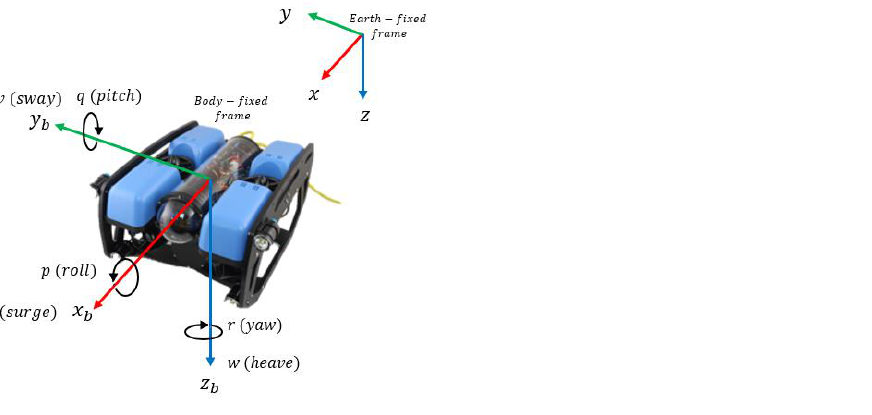
Figure 1. Reference frames for an unmanned underwater vehicle.